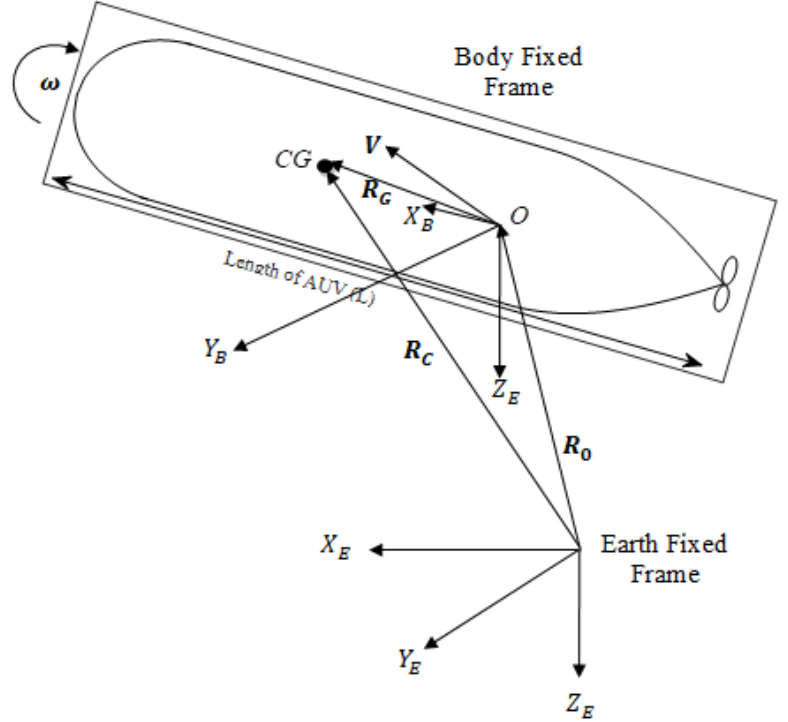
Figure 9. Schematic description about the reference planes—Body Fixed Frame (BFF) and Earth Fixed Frame (EFF).